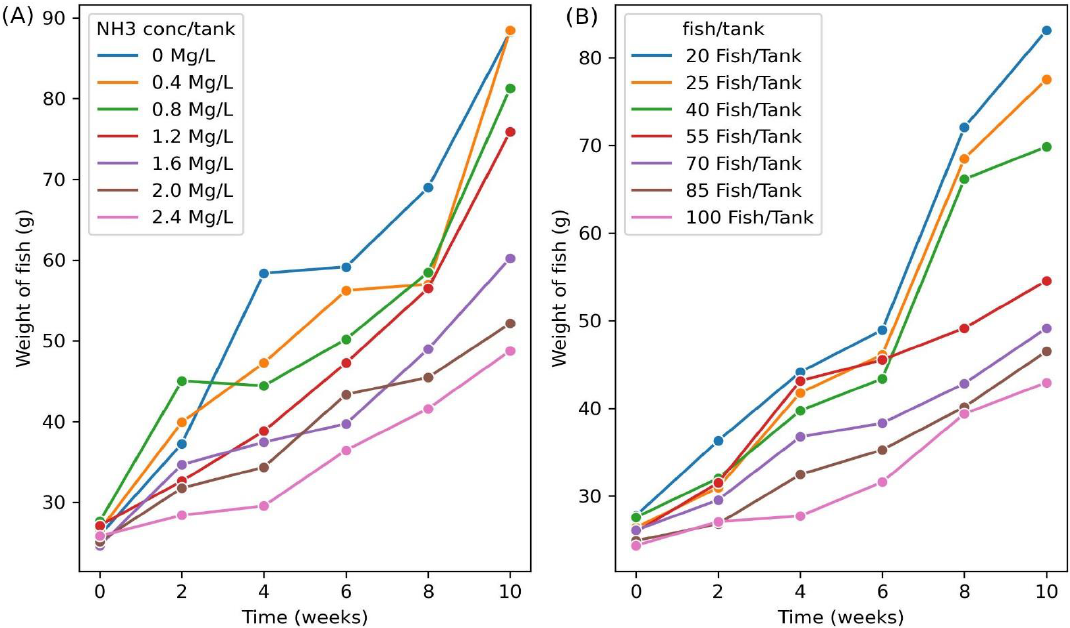
Figure 1. Fortnight weight gain for Nile tilapia subjected to chronic stress. ( A ) Weight gain for fish in